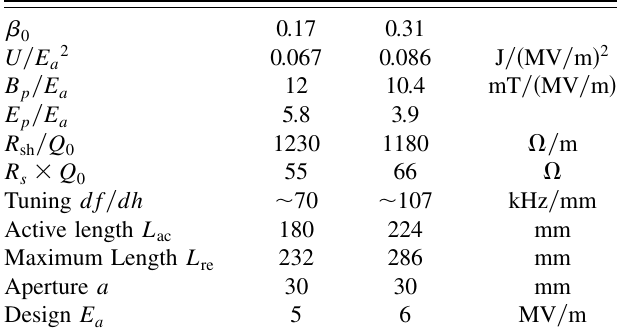
FIG. 3. Detail of the tuning cup before welding.